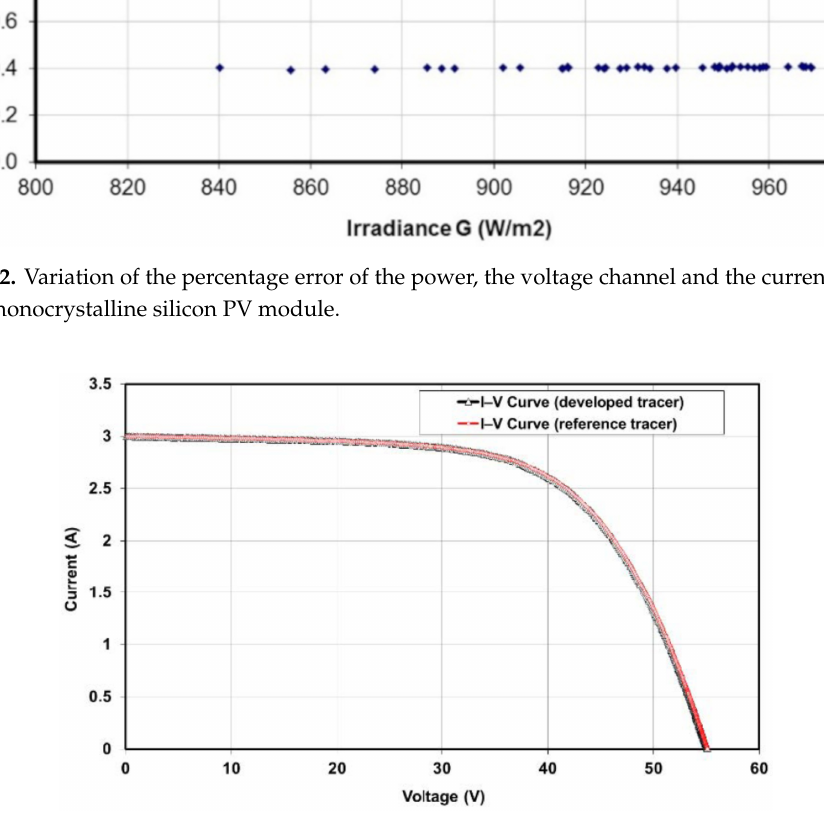
Figure 13. I–V curves obtained simultaneously between the developed tracer and the reference tracer for the thin-film PV